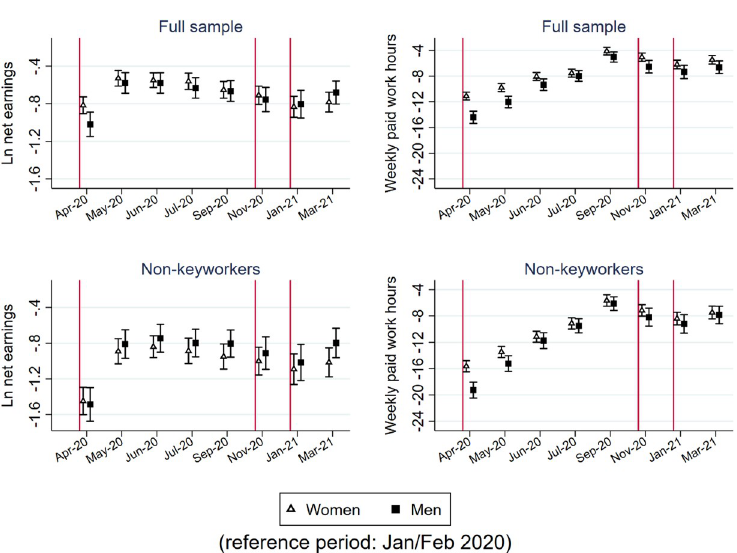
Fig 4. Point estimates and 95% confidence interval of the gender-period interaction models to predict earnings and working time.